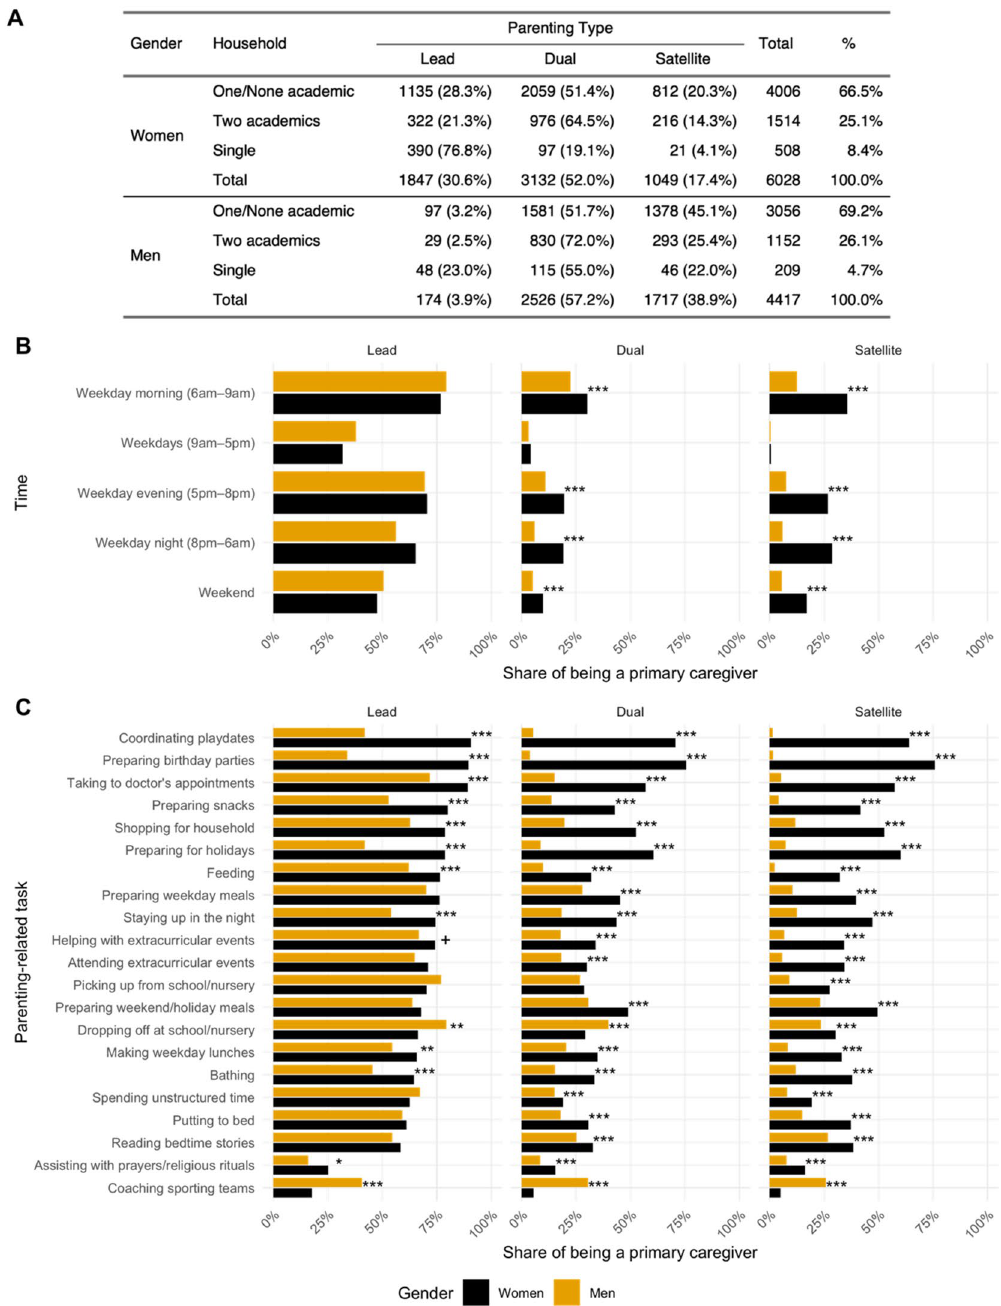
Figure 1. ( A ) Parenting type by gender and household composition. ( B ) Respondents reporting themselves as the primary caregiver at different times of the day, by gender and parenting type. ( C ) Respondents reporting being a primary caregiver for the parenting-related activities, by gender and parenting type. Respondents are considered “primary caregiver” if they reported “Mostly me” or “Almost always me” in taking care of these activities. The asterisks denote the FDR-adjusted p -values from the two-sample tests of proportion between men and women: + p < 0.1, * p < 0.05, ** p < 0.01, *** p <